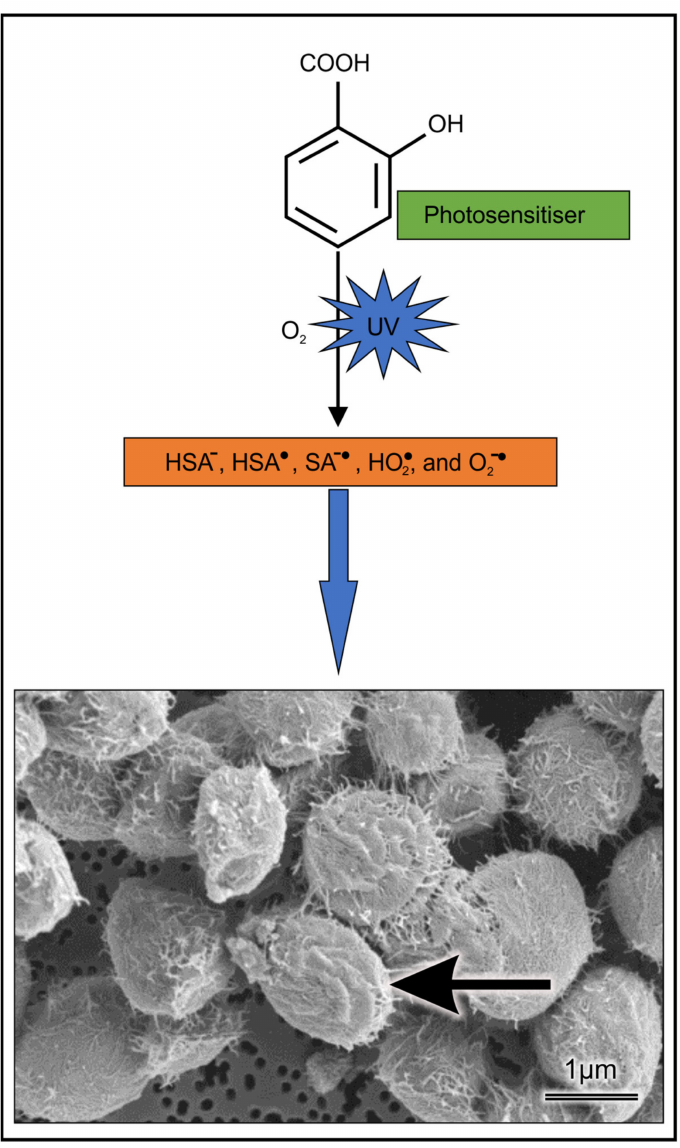
Figure 9. Deleterious effect of accumulated radicals impairs the ultrastructure and integrity of C. neoformans LMPE 046 cell